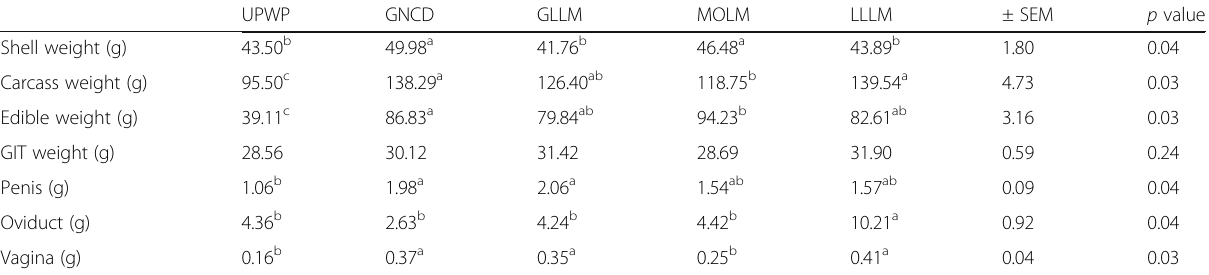
Table 3 Reproductive organ weights of laying snails fed with roughages and concentrate with different leaf proteins